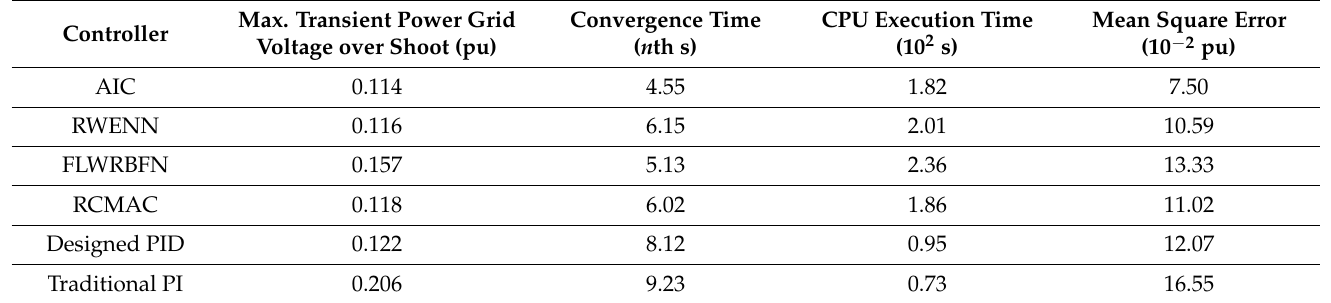
Table 2. Comparison of real power for six controllers given a three-phase short-circuit